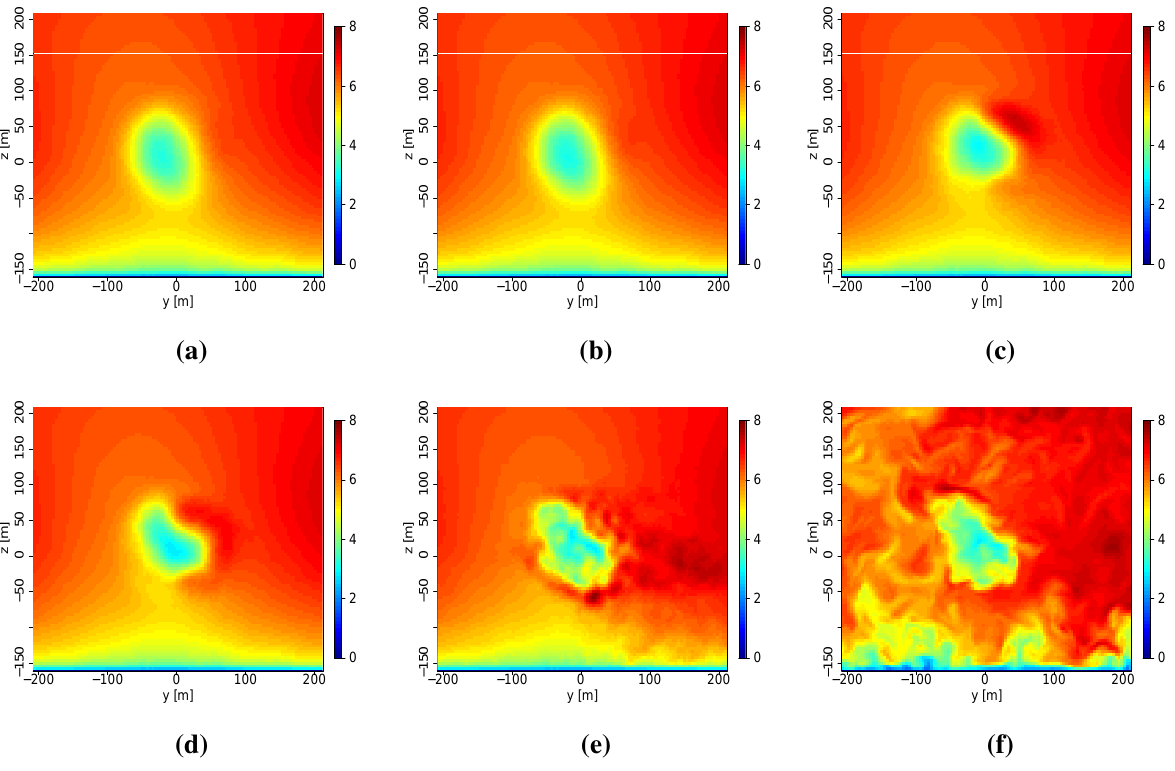
Figure 5. Reconstructions of the velocity field u following Equation (9) ( t = 1000 s). ( a ) Two modes; ( b ) three modes; ( c ) six modes; ( d ) 10 modes; ( e ) 100 modes; ( f ) full